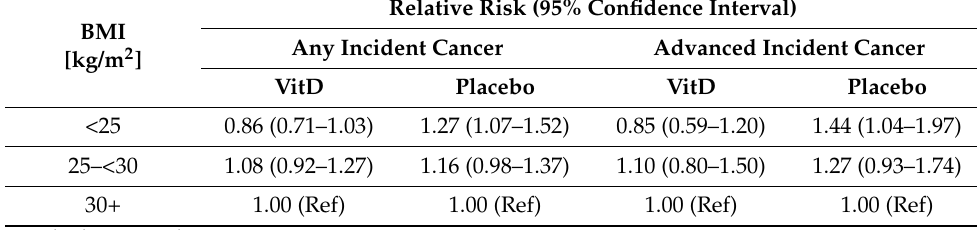
Table 2. Relative risks of any cancer and advanced cancer according to BMI group and vitamin D3 supplementation in the VITAL study (derived from results extracted from references [4,5] and shown in Table